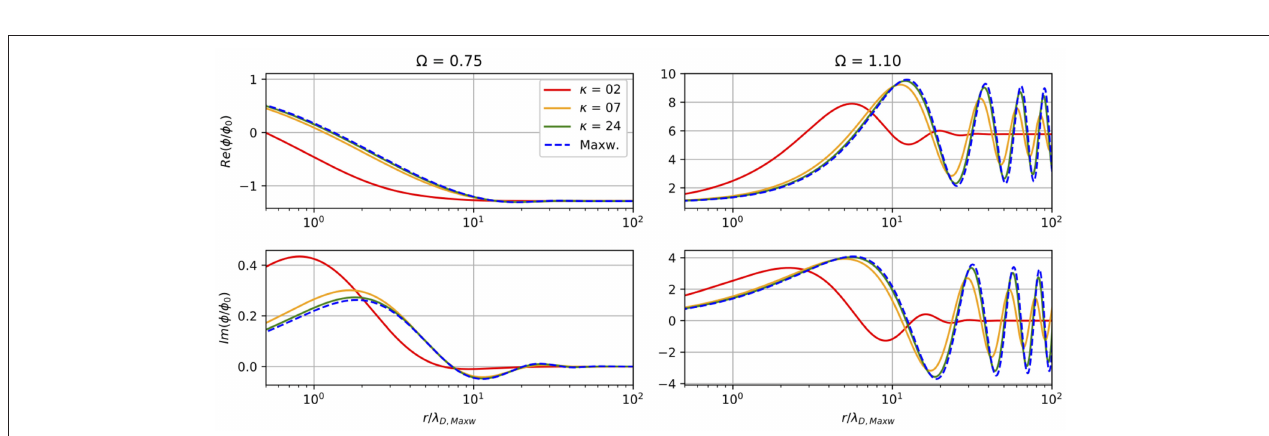
FIGURE 3 | Radiated electrostatic potential for (cid:127) 0.75 (left column) and (cid:127) 1.10 (right column) compared to the distance to the transmitter normalized by = = λ D , Maxw in logarithmic scale : the real part (first panel) and the imaginary part (second panel) for different kappa evdf (here κ and a Maxwellian evdf ( κ ) in dashed → +∞